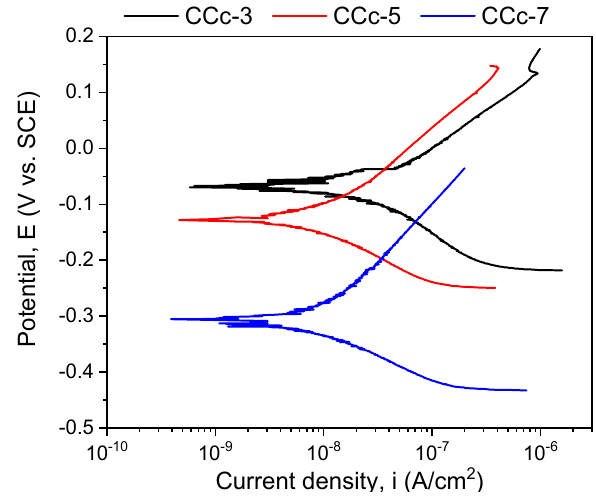
Figure 8. Open circuit potential evolution corresponding to the milled CoCr alloy in all testing me- dia.